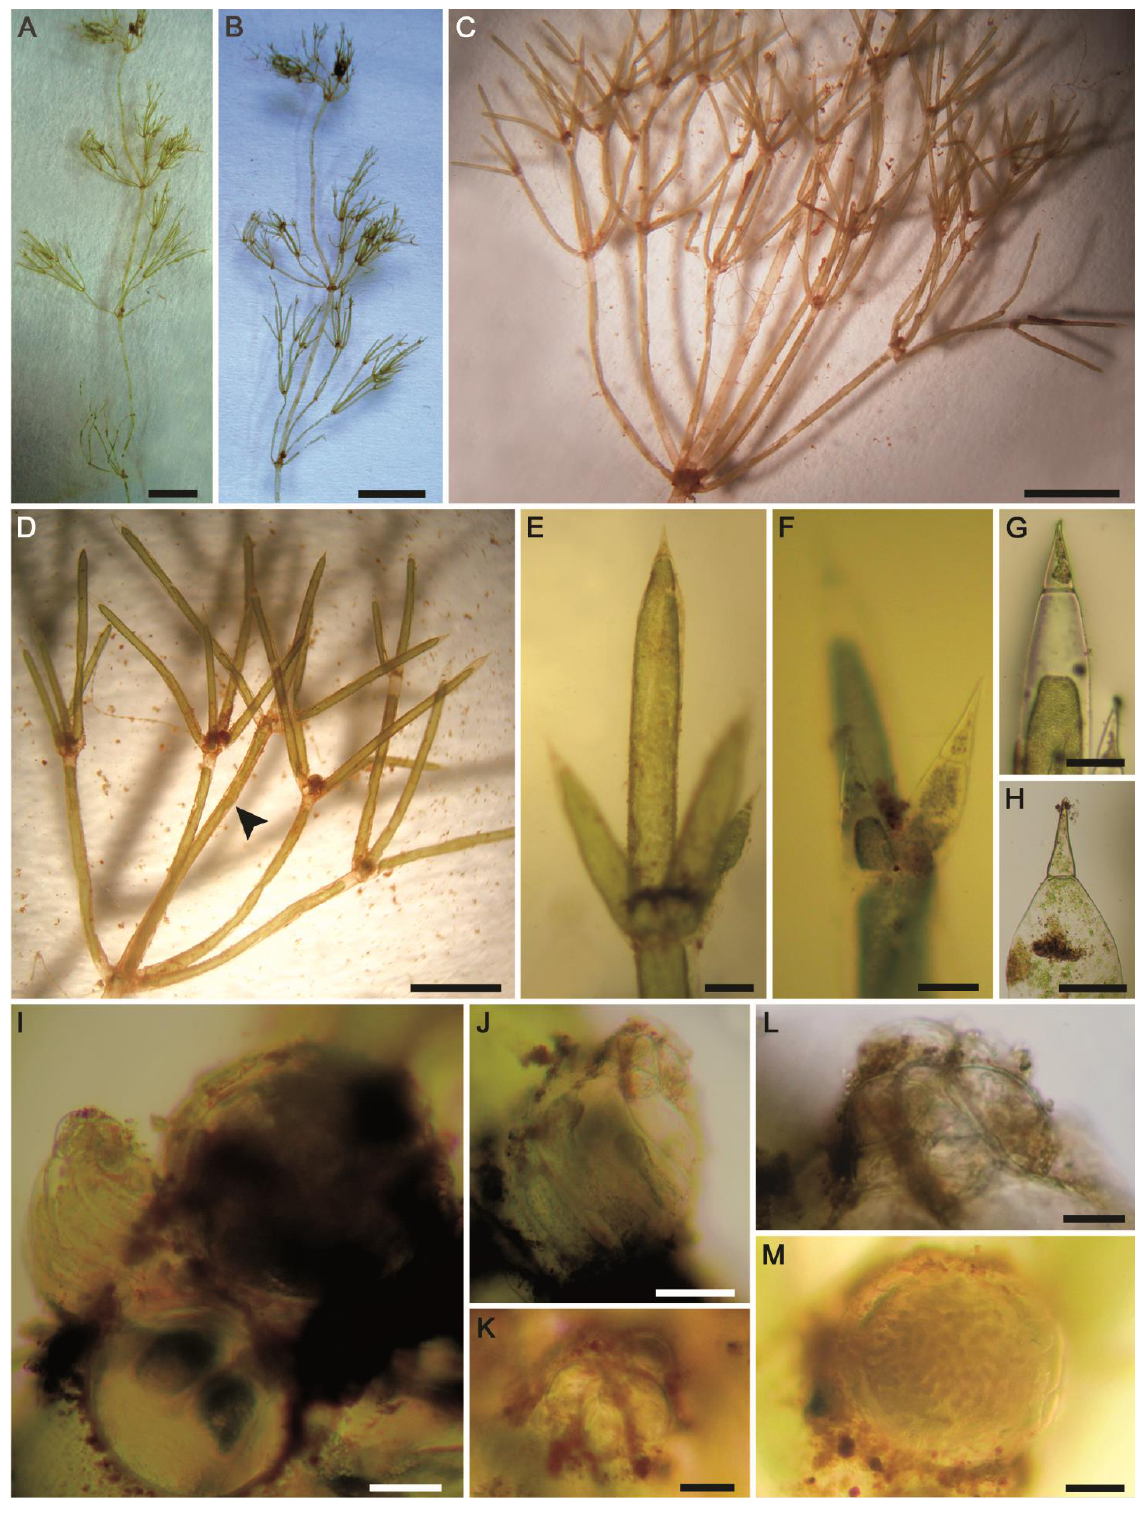
Figure 12. Morphotaxonomic features of Nitella flagellifera found in an agricultural ditch in the El-Dakhla Oasis (the Western Desert of Egypt): ( A , B ) macroscopic habitus; ( C ) 2 – 3-furcate branchlets; ( D ) fertile branchlet with gametangia at the third nodes. Note the central secondary ray (arrowhead); ( E , F ) dactyls; ( G , H ) end cells of dactyls; ( I ) conjoined gametangia; ( J ) oogonium; ( K ) apical view of coronula; ( L ) details of coronula; ( M ) antheridium. Scale bars: ( A,B ) = 1 cm; ( C ) = 2 mm; ( D ) = 1 mm; ( E ) = 200 μ m; ( F – H ) = 100 μ m; ( I – M ) = 50 μ m.